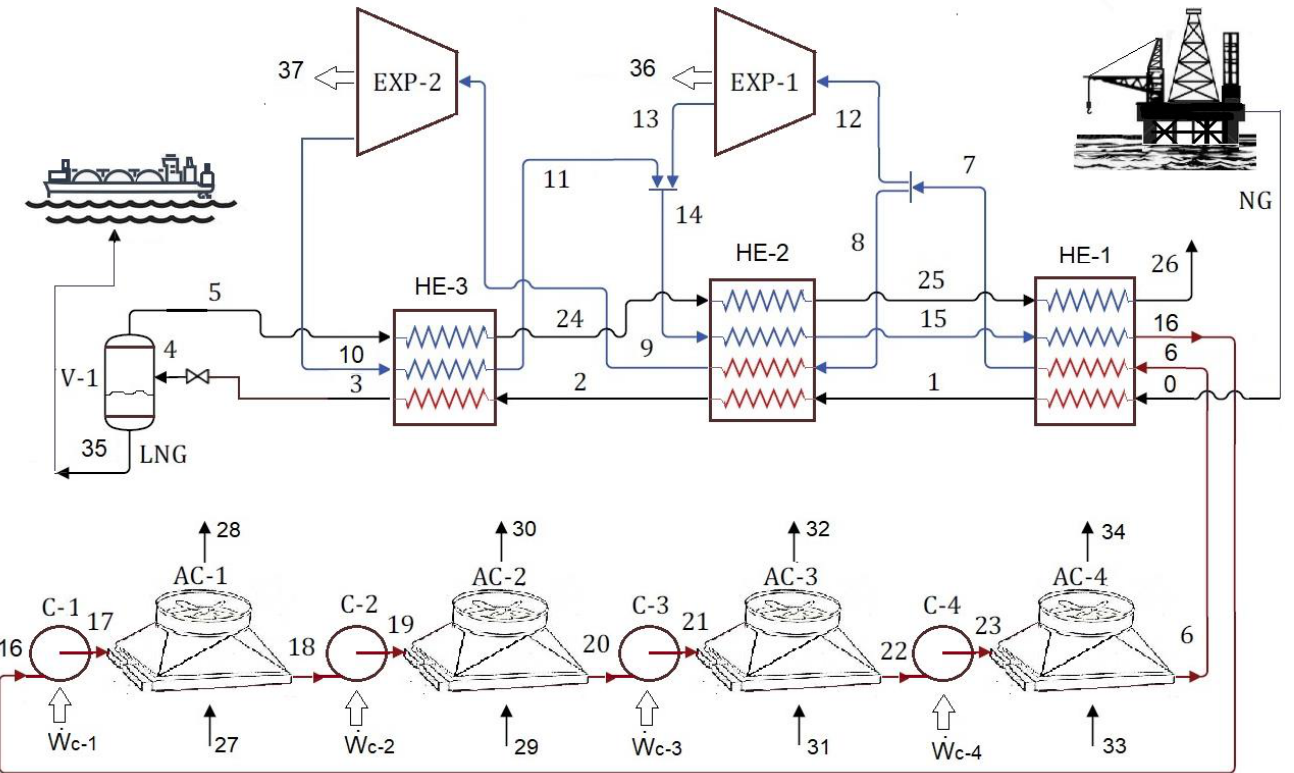
Figure 1. Schematic diagram of natural gas liquefaction with nitrogen expander. The pressurized natural gas (above critical pressure) at point 0 enters the heat ex- changers 1, 2, and 3 and is cooled from 35 °C to −143 °C. The throttling valve reduces the pressure from 58.50 bar to 2.53 bar, liquefying the mixture of natural gas except for nitrogen, which remains gaseous. The lowest temperature of natural gas occurs after the throttling valve, before phase separation. The liquid natural gas exits the vertical separator at point 35, and the gaseous nitrogen flows to three heat exchangers until its disposal into the environment. A secondary system (with compressors, air coolers, and expanders) is used to produce power and refrigerate the liquid natural gas in the heat exchangers. The secondary system uses nitrogen as a working fluid. At the expander outlet, the refrigerant is cool. The refrigerant from the secondary system (at low pressure) and the nitrogen from the vertical separator are heated while passing through the heat exchangers. In these heat exchangers, the natural gas is cooled until its liquefaction. The refrigerant of the secondary system exits HE-1 at point 16 and undergoes a four-stage compression with intercoolers. The pairs of compressor/air coolers alternate from compressor C-1 at 5.95 bar until